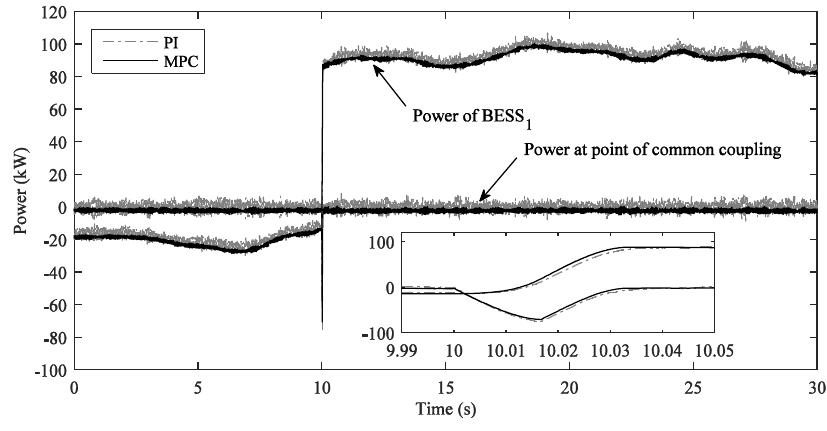
Figure 7. Real power at point of common coupling and real power of BESS 1 .